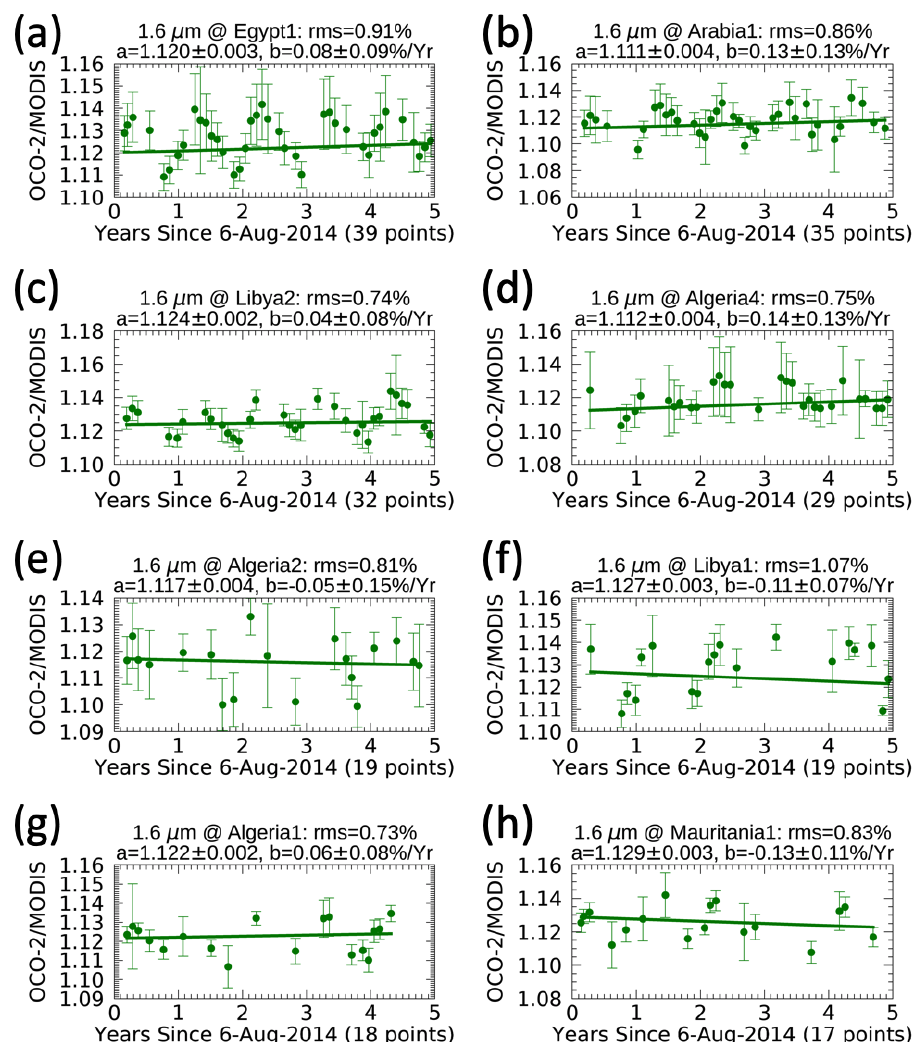
Figure A1. Five-year time series ofthe OCO-2/MODIS radiance ratio for OCO-2 Band 2 over eight desert sites: Panel ( a ) is over Egypt1; Panel ( b ) over Arabia1; Panel ( c ) over Libya2; Panel ( d ) over Algeria4; Panel ( e ) over Algeria2; Panel ( f ) over Libya1; Panel ( g ) over Algeria1; Panel ( h ) over